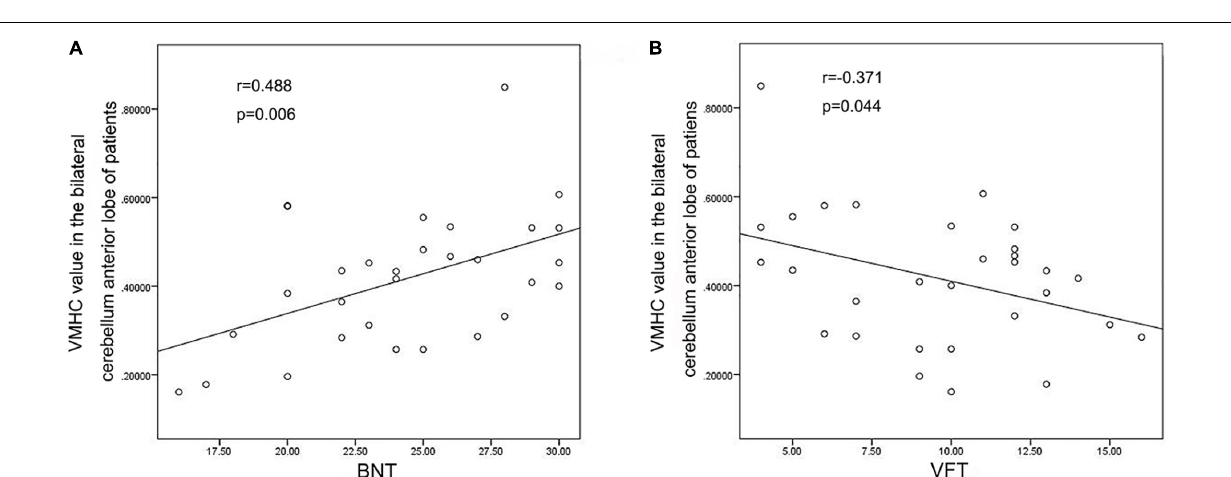
FIGURE 2 | Correlation analysis Results. (A) VMHC values of bilateral cerebellum anterior lobe were positively correlated with BNT scores; (B) VMHC values of bilateral cerebellum anterior lobe were negatively correlated with VFT